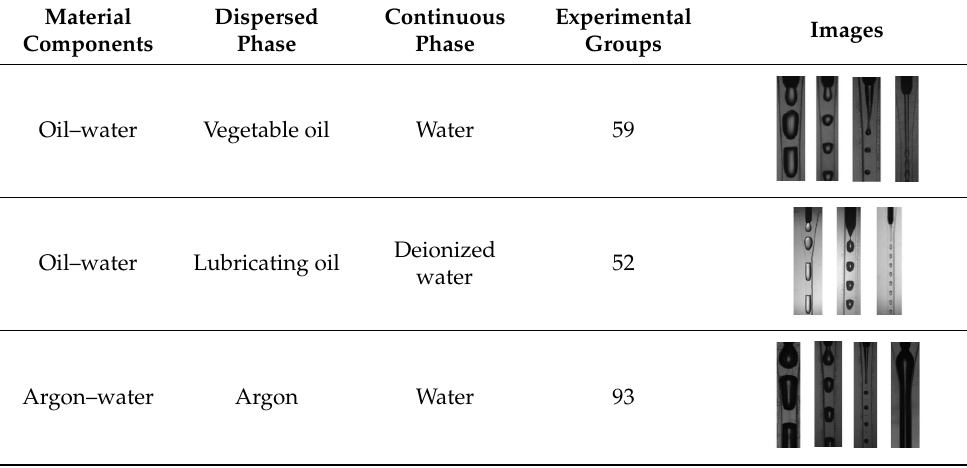
Table 5. Experiments for flow pattern prediction.